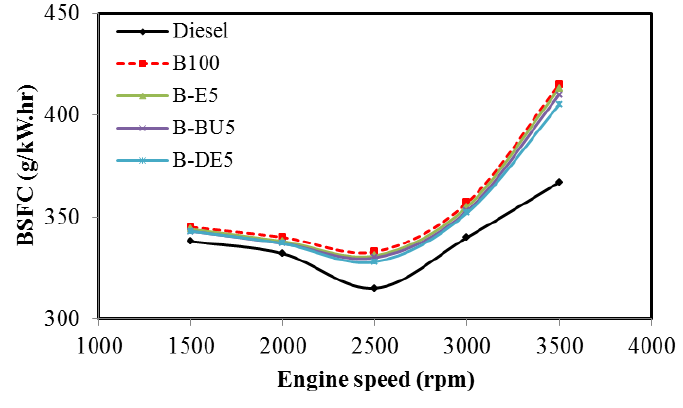
Figure 9. Brake specific fuel consumption with mineral diesel fuel, palm oil methyl ester and palm oil methyl ester with different additives at 5% blending ratio (the tests conducted at increasing engine speed and half open